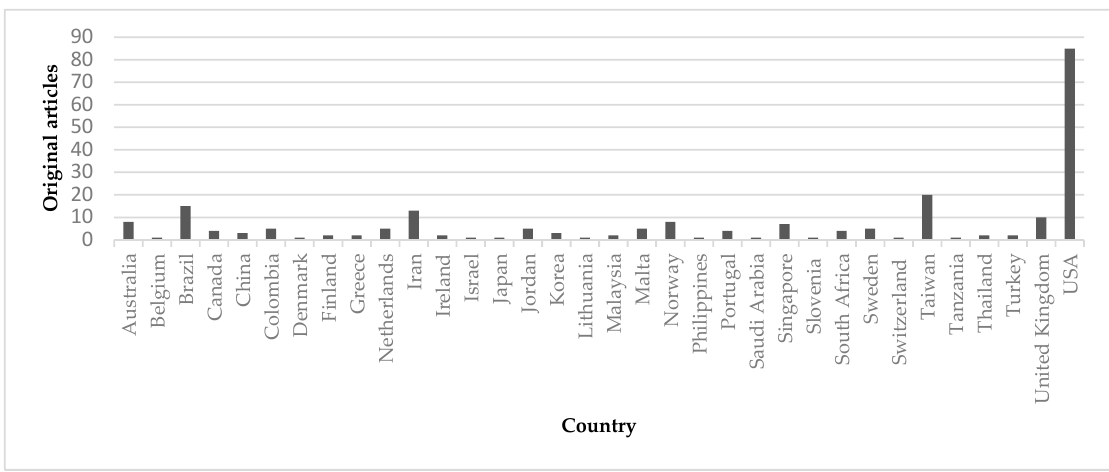
Figure 2. Distribution of results by country of research.